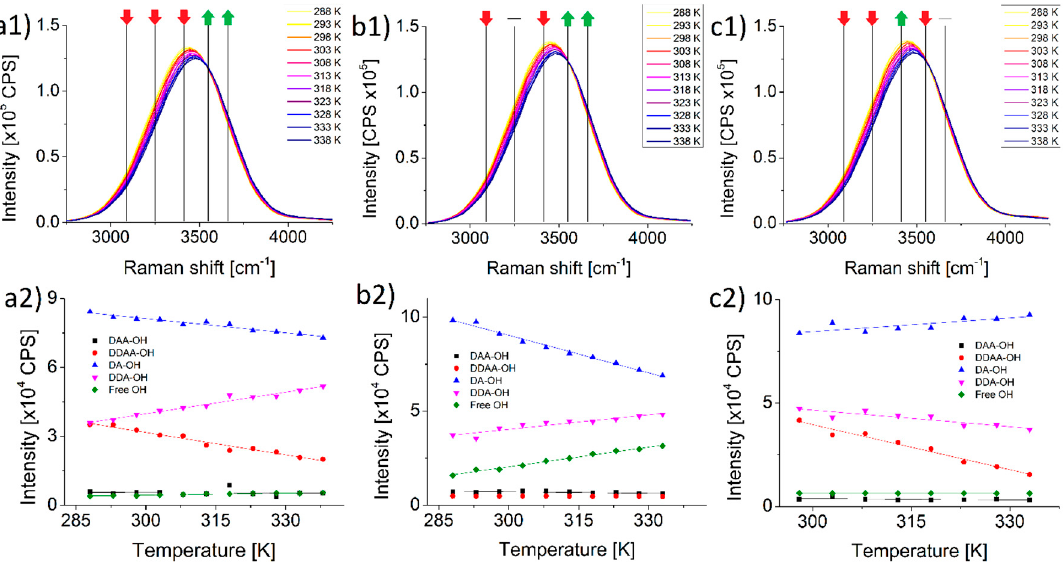
Figure 3. Temperature dependent Raman signals of ( a1 ) pure water, ( b1 ) 100 mM aqueous K 2 SO 4 and ( c1 ) 100 mM aqueous Na 2 SO 4 solutions. Changes of the amplitudes of Gaussians used to superpose the Raman spectra plotted against temperature ( a2 , b2 , c2 ). Red and green arrows indicate the decrease and increase in the amplitude of the respective deconvoluted Gaussians caused by increasing temperature, a dash indicate no significant change in these.